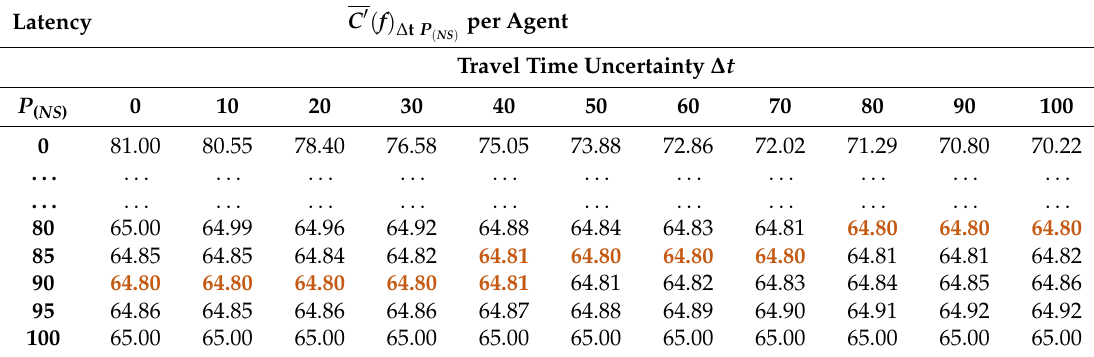
Table 2. Lowest average latency times C (cid:48) ( f ) for varying ∆ t and P ( NS ) are marked with